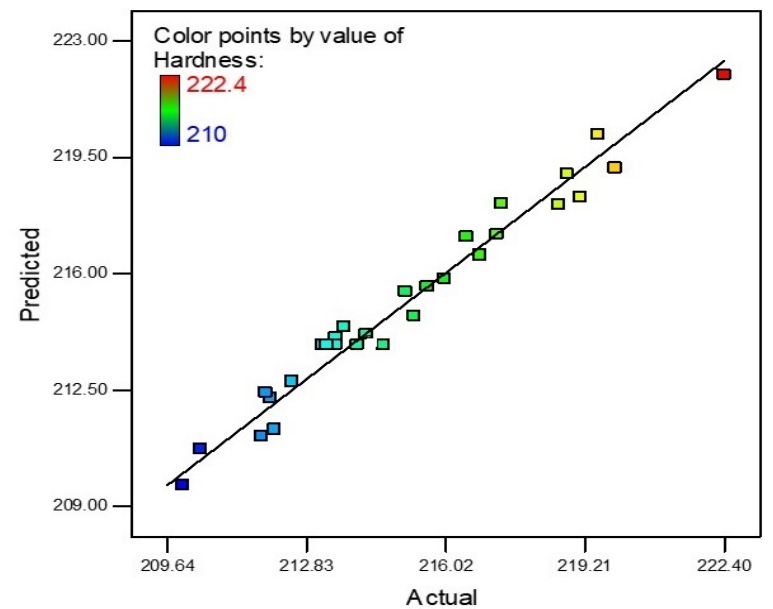
Figure 6. Micro hardness predicted vs. actual.